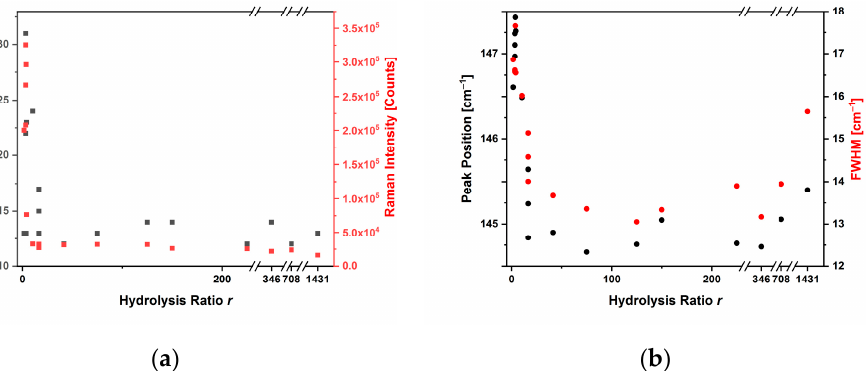
Figure 6. Plots correlating the crystallite diameter and intensity ( a ), position and width ( b ) of the Raman E g(1) peak with the hydrolysis ratio used in the anatase acid synthesis.